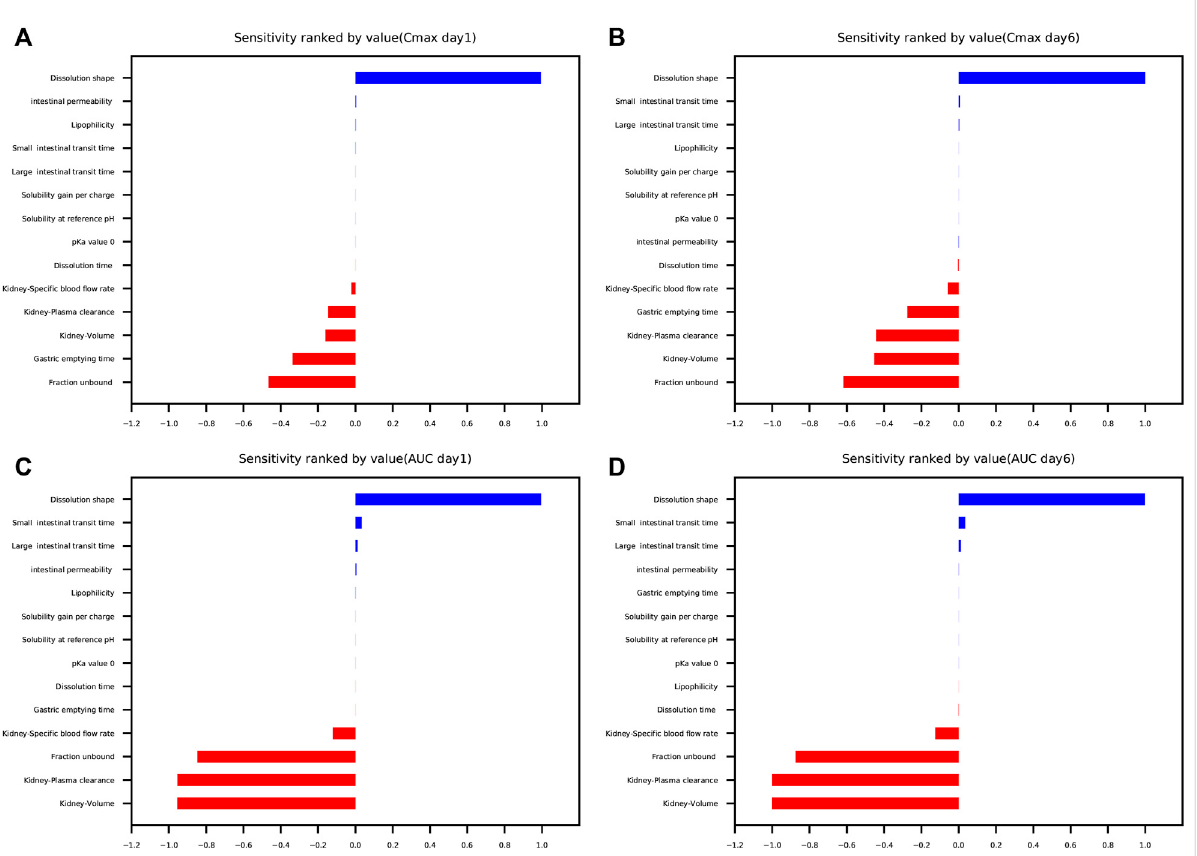
FIGURE 7 Parameter sensitivity analysis performed on the human PBPK model with PK-Sim ® . Sensitivity was measured as the relative changes of C max on day1 (A) ,C max onday6 (B) ,AUC 0-t onday1 (C) ,AUC 0-t onday6 (D) ofschaftosideintheclinicalstudy.Variationrangewas0.1withmaximumnumber of steps =